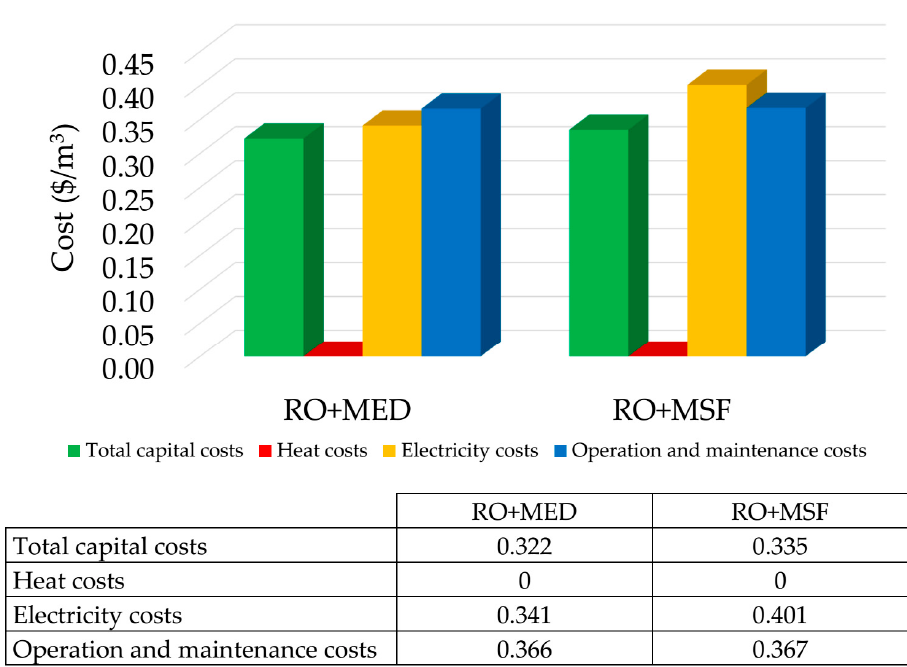
Figure 4. Levelized cost of various hybrid desalination processes for the first case.